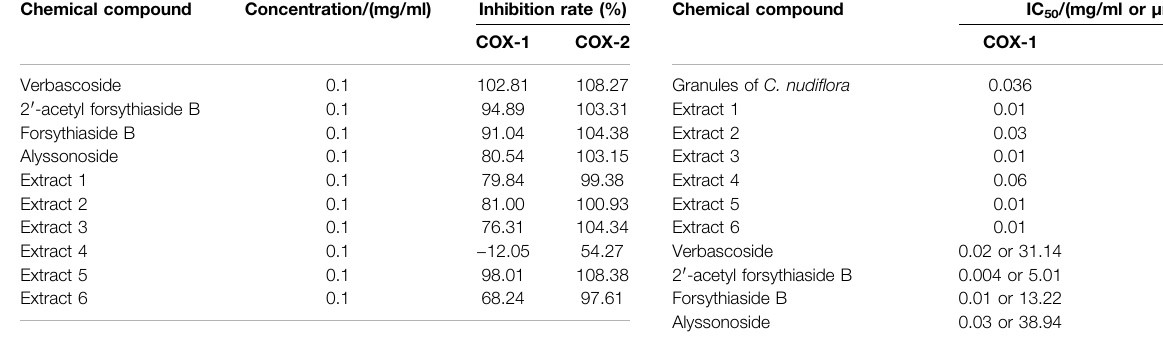
TABLE 6 | Cyclooxygenase (COX-1 and COX-2) inhibition results. Chemical compound Concentration/(mg/ml)